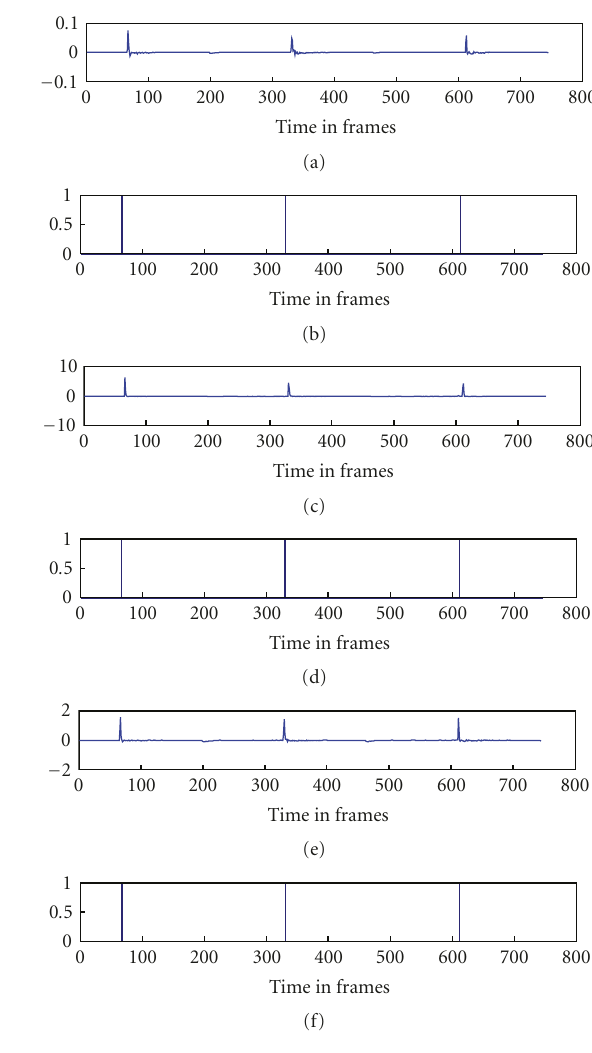
Figure 12: Comparison between the detection functions for the piano signal (see Figure 9(c)). Plots (a), (c), and (e) are detection ( k ), h o ( k ), and h o ( k ), respectively, and plots (b), functions h o a r b (d), and (f) are the onsets localised correspondingly using these detection functions. The detection functions reveal strong peaks at the onset locations, while remaining relatively flat for the period of note decaying, due to the relatively small variations of dynamics of the piano